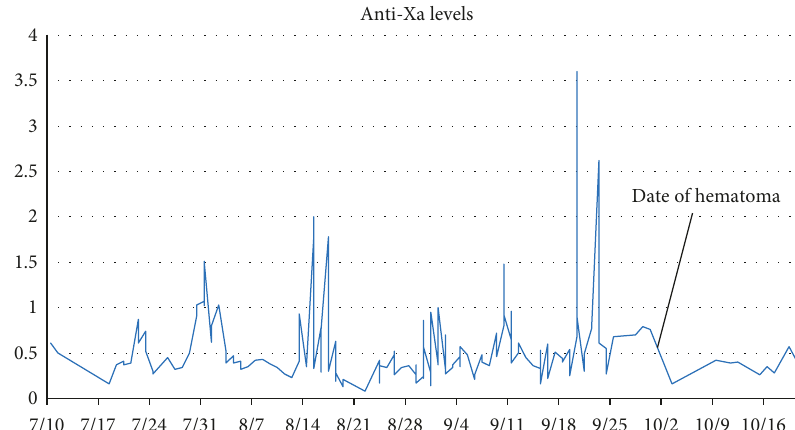
Figure 1: Anti-Xa levels of the patient throughout his hospital admission. LMWH doses are not included as they varied from day to day following the patient’s lab results. For reference, the regimen used after September 7 was as follows: repeat anti-Xa 4 hours after next dose. 0.35–0.49 units/mL: increased dose by 10%, repeat anti-Xa 4 hours after next dose. 0.5–0.59units/mL: keep same dose, repeat anti-Xa next day. 0.6–1.0 units/mL: contact on call fellow for further recommendations. 1.0–1.5units/mL: decrease dose by 20%, repeat level before next dose. 1.6–2units/mL: hold dose for 3h, then decrease dose by 30%. Repeat level before next dose, then 4h after next dose.